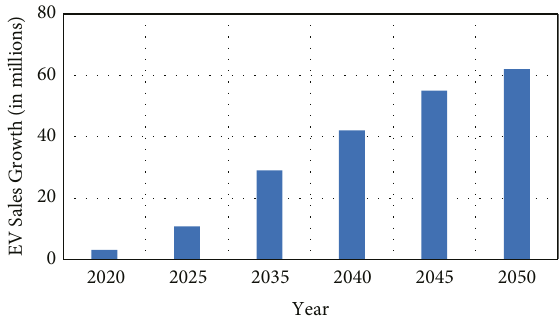
Figure 1: Global EV sales growth (2020–2050). Table 1: Classifcation of batteries used in EV.